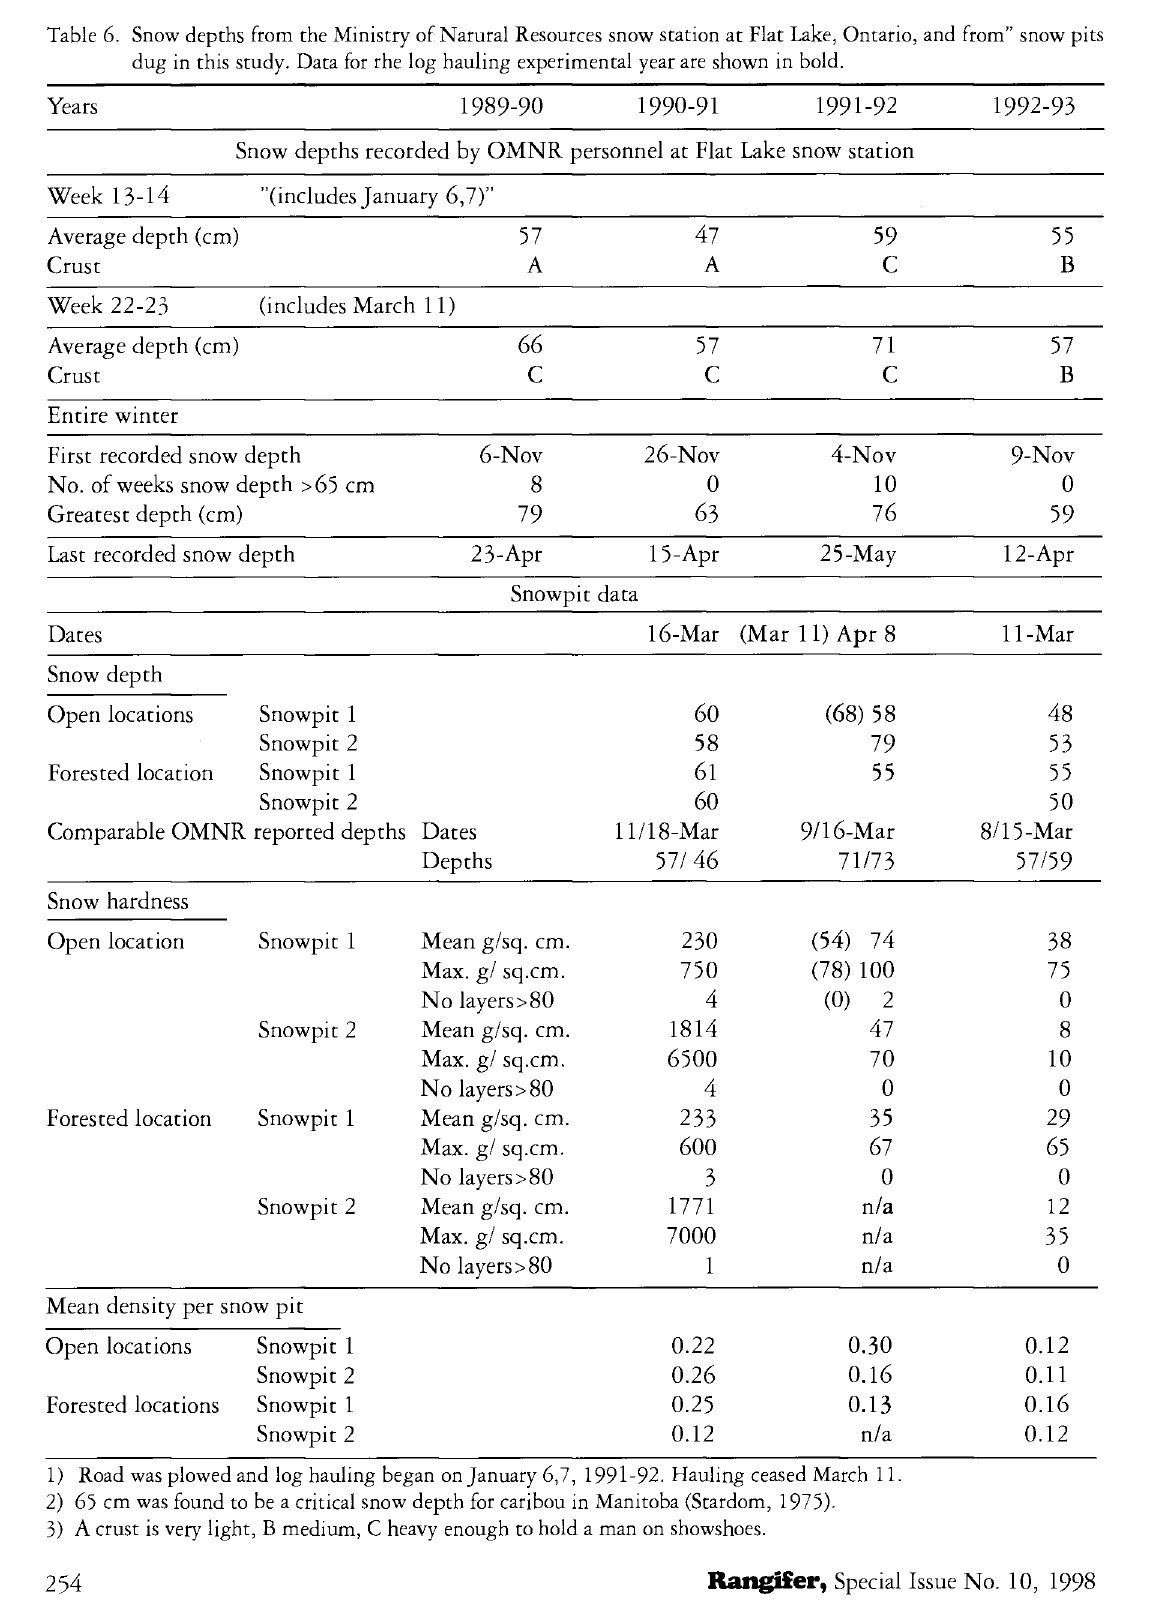
Table 6. Snow depths from the Ministry of Narural Resources snow station at Flat Lake, Ontario, and from" snow pits dug in this study. Data for rhe log hauling experimental year are shown in